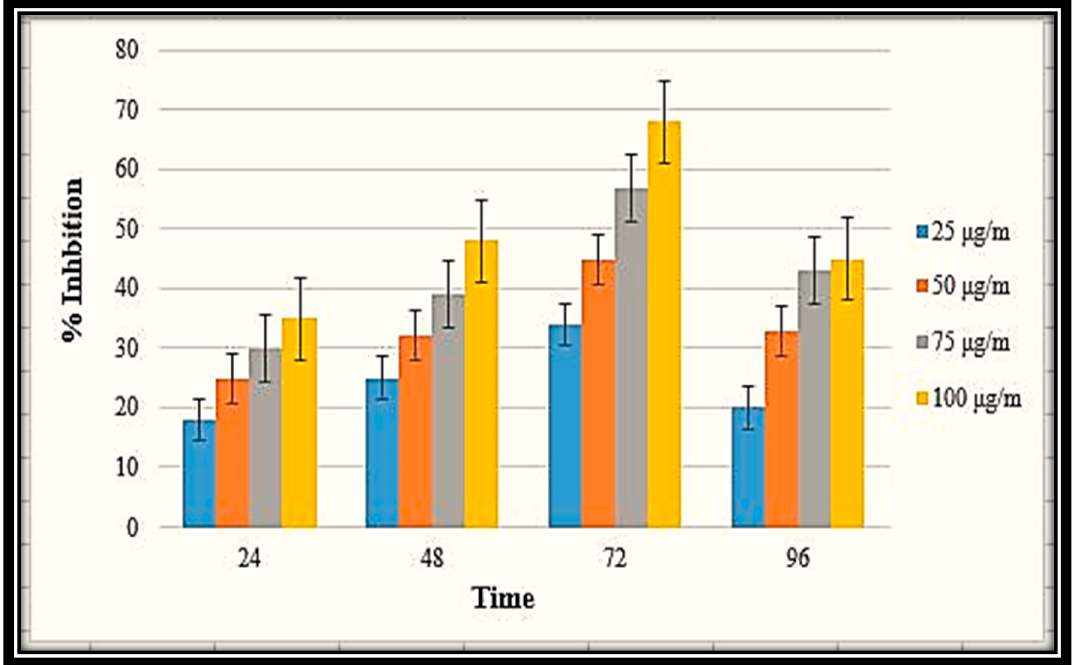
Figure 11. Antileishmanial potential of MB-ZnO at various